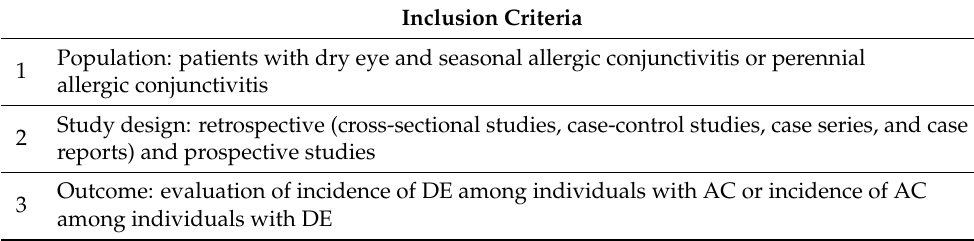
Table 1. Study inclusion and exclusion